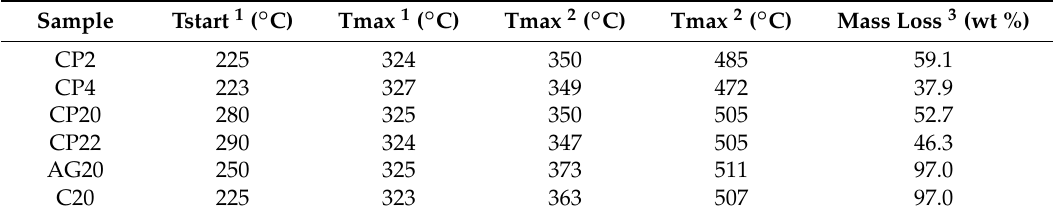
Figure 6. DSC curves of CP4 (blue line), CP22 (red line) versus AG20 (short dash line), C20 (black line). Table 2. Characteristic features of thermal decomposition of